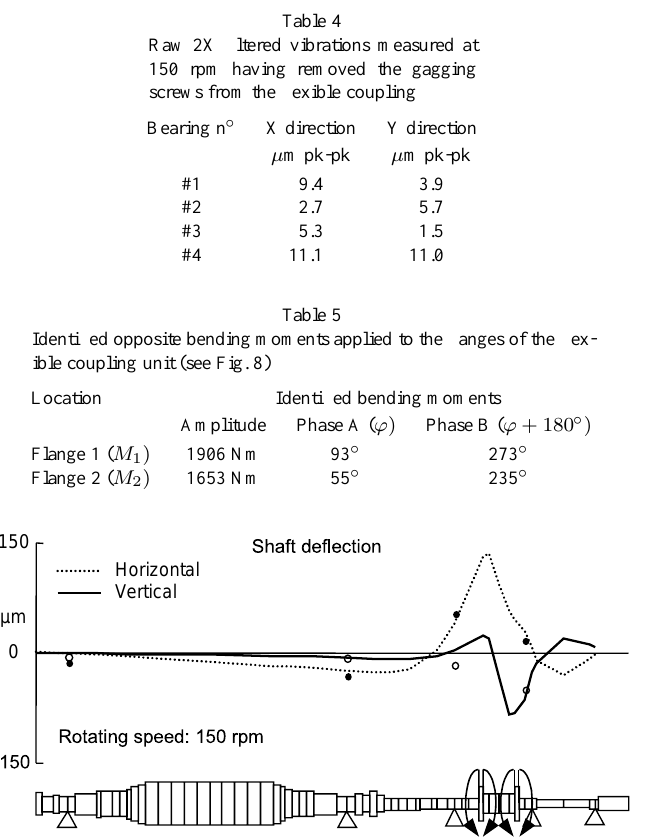
Table 4 Raw 2X filtered vibrations measured at